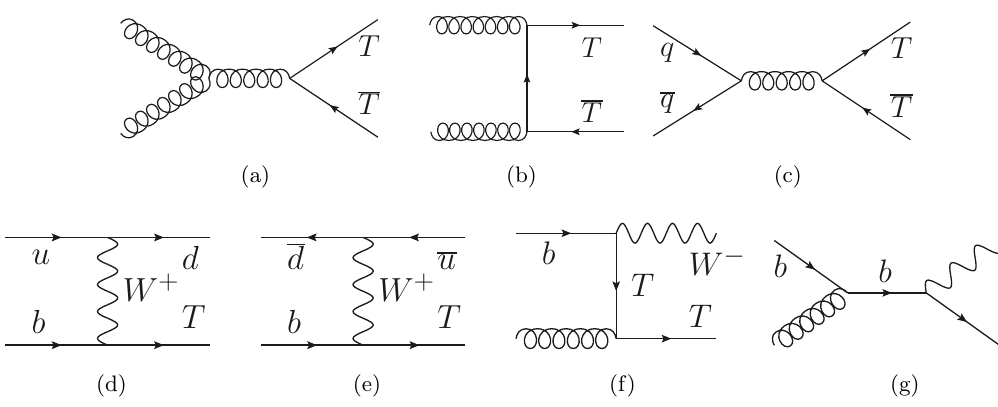
Figure 2 . Standard production modes of top partners at the LHC for (a-c) pair production, (d,e) top partner plus jet production, and (f,g) top partner plus W (cid:0) production. There are conjugate processes for (d-g) that are not shown here.